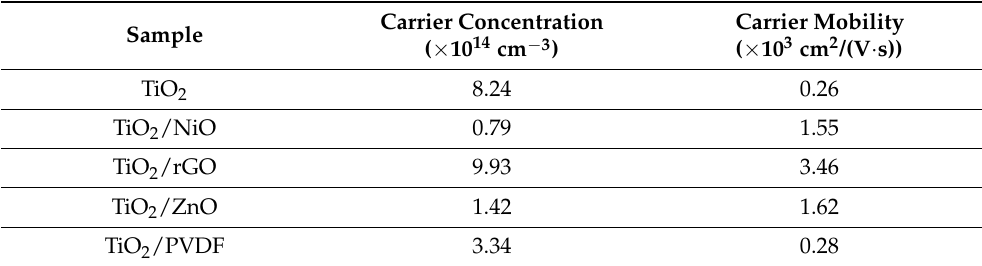
Table 2. Hall effect measurement of TiO 2